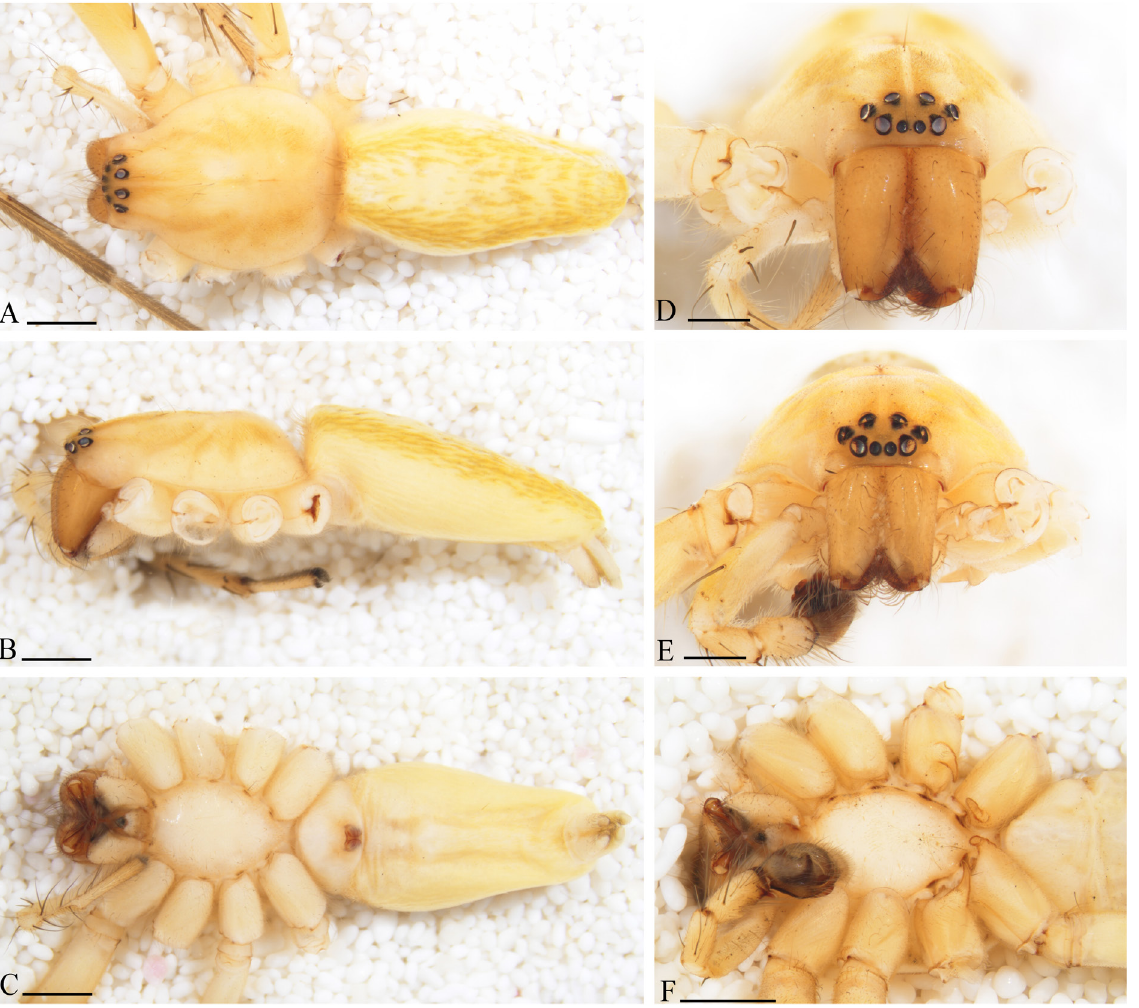
Male Total length 8.0. Cephalothorax and abdomen pattern as in female, except darker and yellow chelicerae (Fig. 31E). Coxa II ventral surface smooth. Coxa III tubercle bifurcated, with posterior bent spine and anterior tubercle. Coxa IV spur bent and with broad base (Figs 31F, 33E–F). Embolus filiform and translucent. Pedipalp tibia longer than wide. RTA posterior branch short and shaped as bent lamella. Prolateral apophysis of palpal tibia present. Ventral branch of median tibial apophysis present (Figs 32A–D, 33A–D). Cephalothorax length 3.41, thoracic width 2.59, cephalic width 1.19. Clypeus height 0.12. Eye diameters: AME 0.09, ALE 0.12, PME 0.12, PLE 0.15. Eye interdistances: AME–AME 0.05, AME–ALE 0.04, ALE–PLE 0.11, PME–PME 0.15, PME–PLE 0.12. Femur lengths: I 4.63, II 4.1, III 3.17, IV 4.63. Leg spination as in female except: femur I r0-2-1. Femur II p0-1-2. Variation Females (N = 6): total length 8.9 (± 0.39), cephalothorax length 3.8 (± 0.11), thoracic width 2.89 (± 0.06), cephalic width 1.52 (± 0.06), femur I 4.41 (± 0.04). Males (N = 4): total length 8.03 (± 0.37), cephalothorax